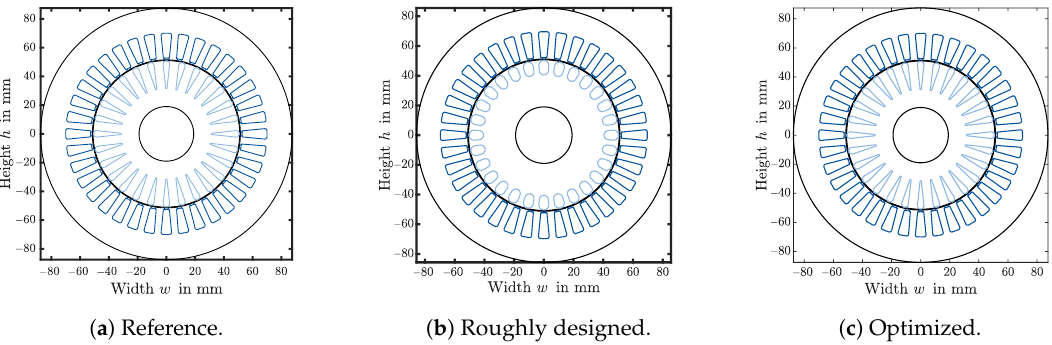
Figure 4. Representation of the cross sectional area of the reference ( a ), roughly designed ( b ) and optimized machine ( c ). Table 1. Rated and geometrical parameters of the reference machine.